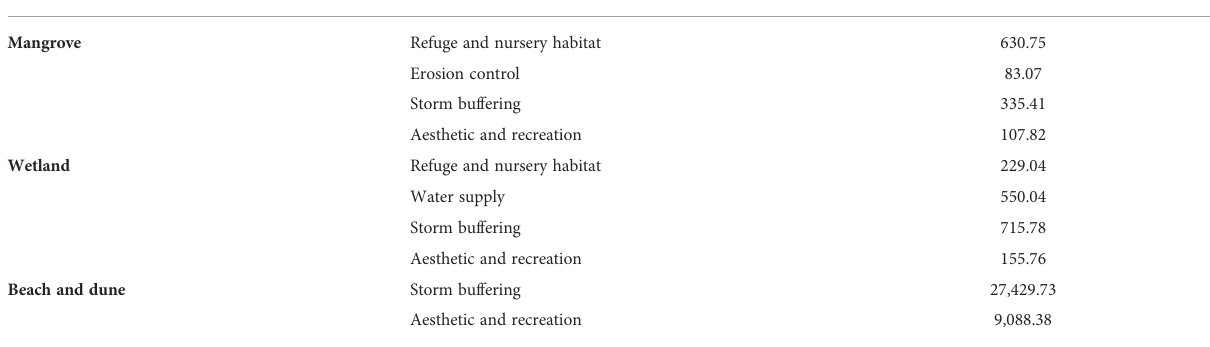
TABLE 1 Average yearly valuation of coastal ecosystem services for the year 2020. Coastal ecosystem